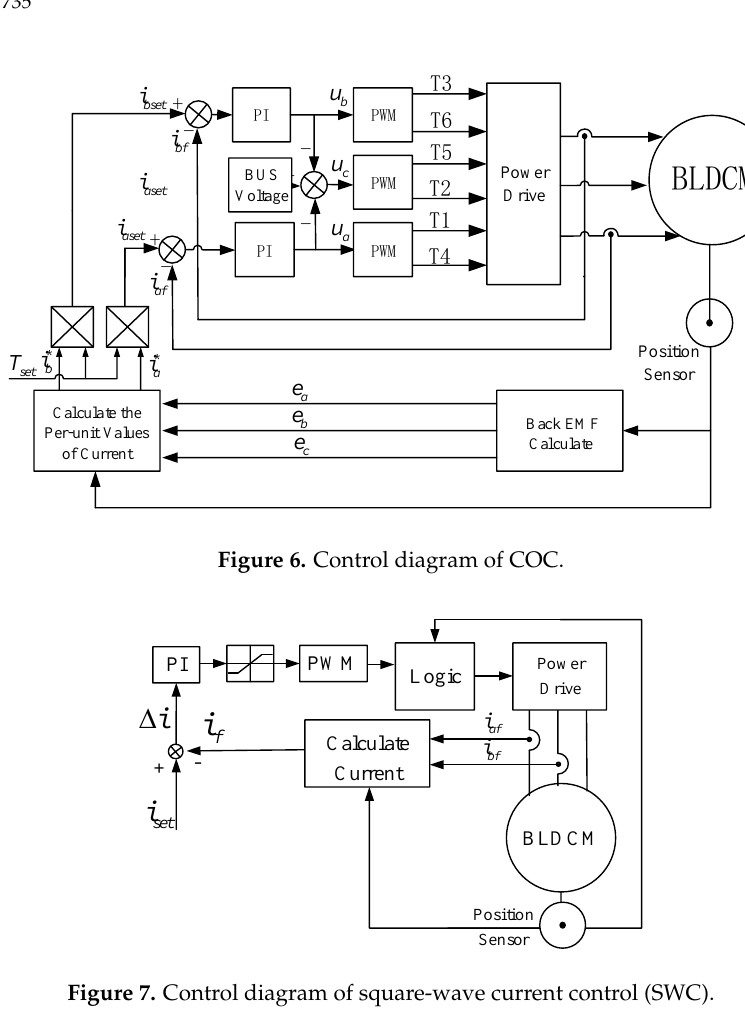
Figure 7. Control diagram of square-wave current control (SWC).